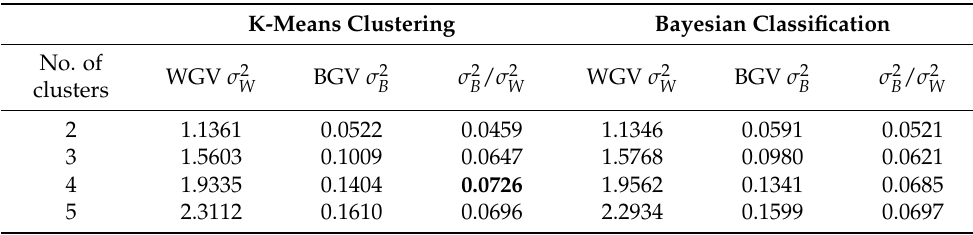
Table 2. Dependence of ordering results on the subjectively selected number of clusters. The greatest ratio of between-group variance (BGV) to within-group variance (WGV) σ 2 B / σ 2 W assures that the overlap of homogeneous clusters is minimised. In our dataset, the greatest variance ratio (bolded numbers) was obtained for four clusters. K-Means Clustering Bayesian Classification No. of